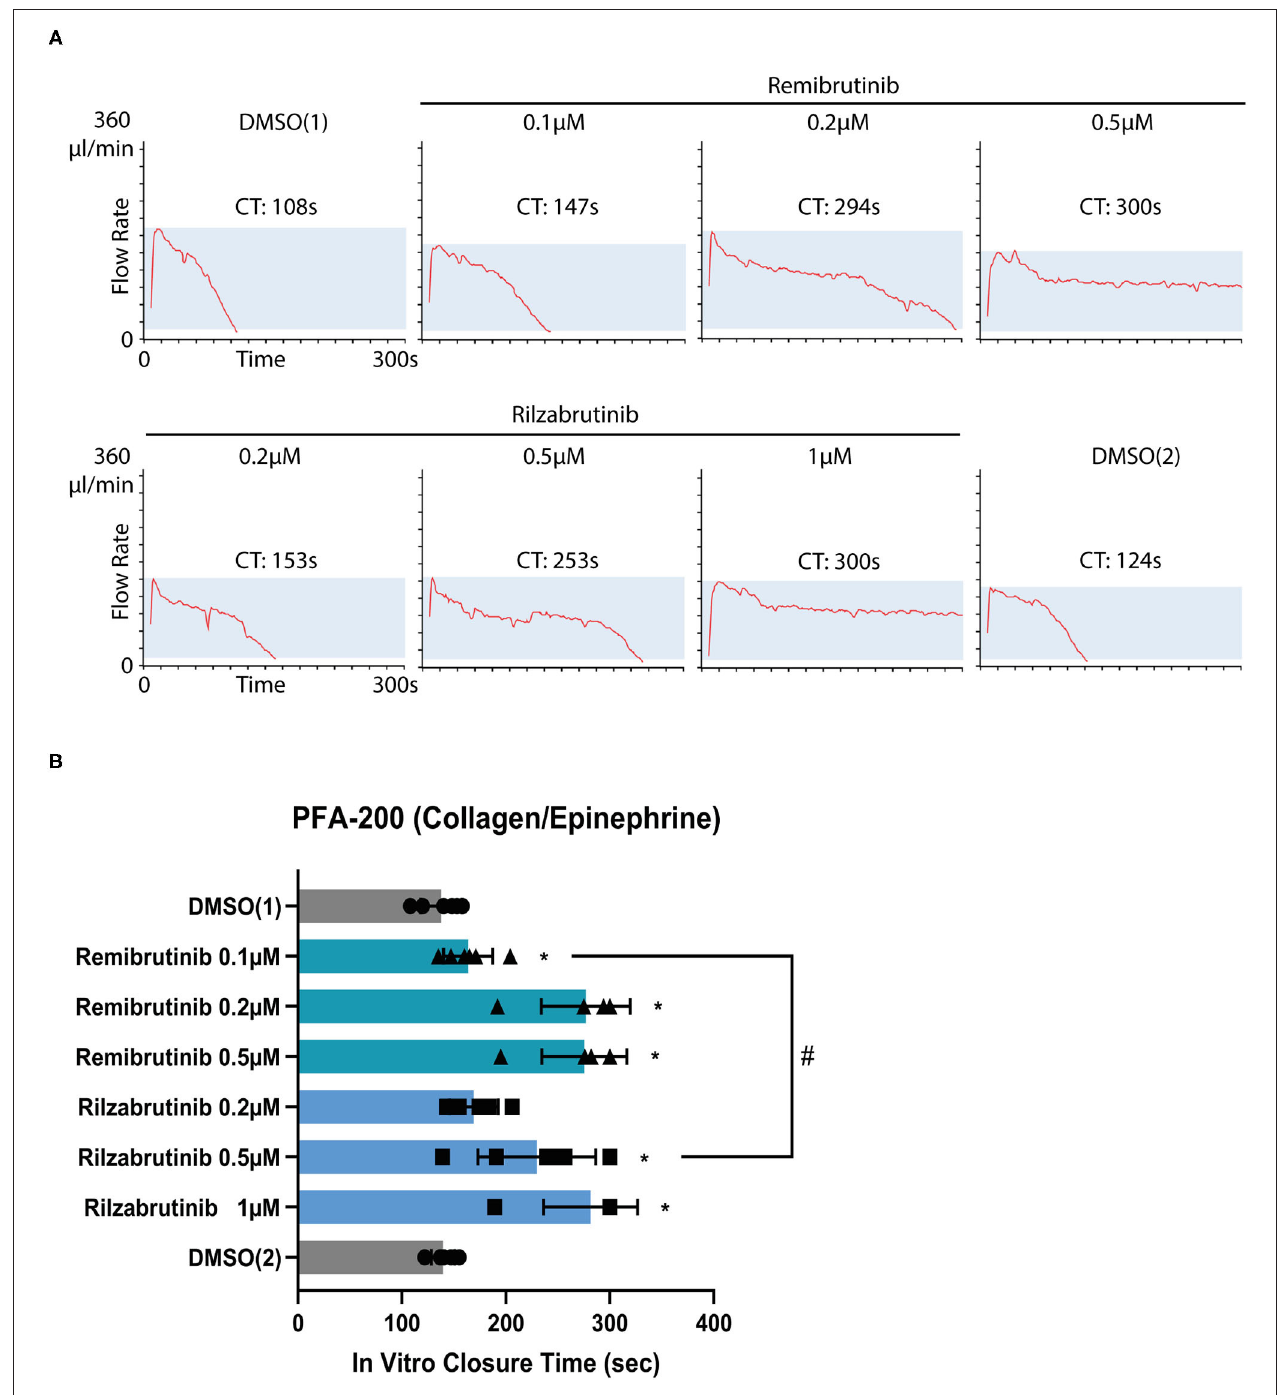
FIGURE 4 | Effect of remibrutinib and rilzabrutinib on bleeding time in vitro . Citrate anticoagulated blood samples were pre-incubated for 1h at 37 ◦ C with solvent (DMSO, 0.1%) or increasing concentrations of remibrutinib or rilzabrutinib and then transferred to collagen/epinephrine cartridges. The in vitro closure time (CT) was measured with the PFA-200. DMSO (1) and DMSO (2) control samples were measured at the beginning and end of the experiment, respectively. (A) Representative PFA-200 tracings. (B) The aligned dot plot bar charts show CT values of different concentrations of remibrutinib and rilzabrutinib. Values are mean ± SD ( n = 6). Statistical analysis was carried out using the Wilcoxon matched-pairs signed rank test comparing against DMSO1 (* p < 0.05) or concentrations of remibrutinib (0.1 µ M) and rilzabrutinib (0.5 µ M) that inhibited Btk-dependent pathways of platelet aggregation by > 90% (# p < 0.05).